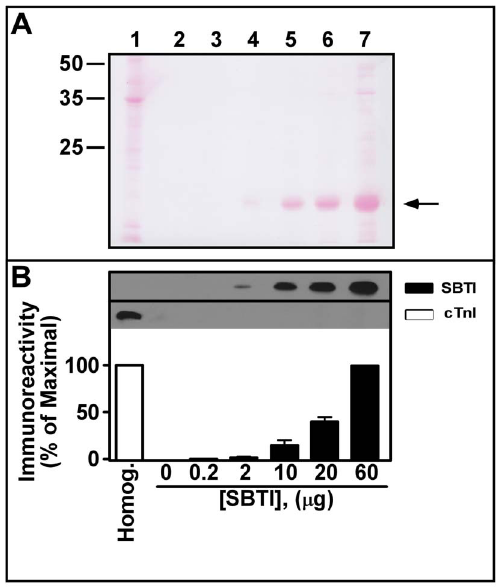
Figure 3. Commercially available soybean trypsin inhibitor (SBTI) preparations are devoid of cardiac troponin I (cTnI). Lane 1 contains 35 m g of rat left ventricle homogenate prepared as in Figure 1. Lanes 2–7 contain 0–60 m g of commercially available SBTI. All samples were subjected to SDSPAGE and proteins were electro- transferred onto nitrocellulose paper (NCP). The resulting blots were stained for total proteins using Ponceau S stain (Panel A) and then subjected to Western blot analyses for the detection of SBTI and cTnI (Panel B). Note the absence of cTnI immunoreactivity in the commercially available SBTI samples. Typical autoradiographs are shown in the top of Panel B with the histogram representing Mean 6 S.E. densitometry values from all autoradiographs (expressed as the % of maximal densitometry scores) from 5 independent experiments.